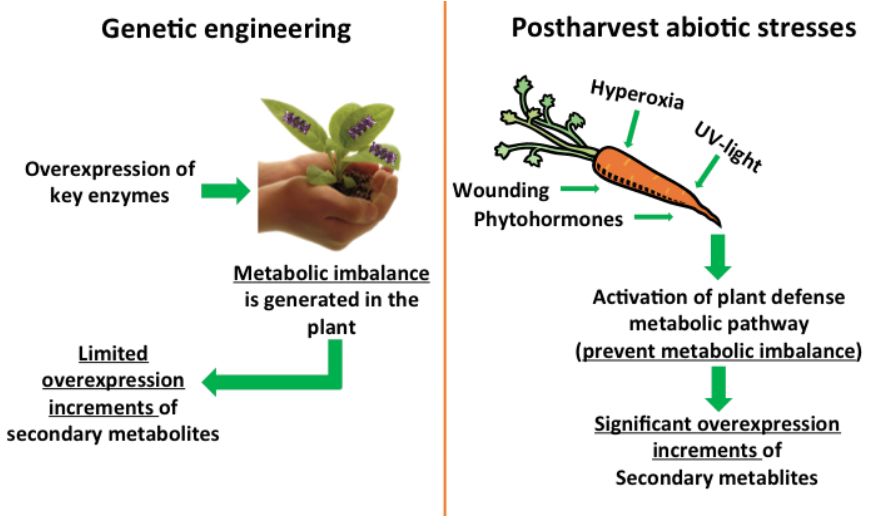
Figure 1. Comparison between genetic engineering and postharvest abiotic stresses as secondary metabolites overexpression